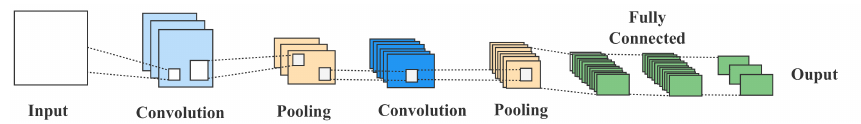
Figure 1. Illustration of a common DNN model.